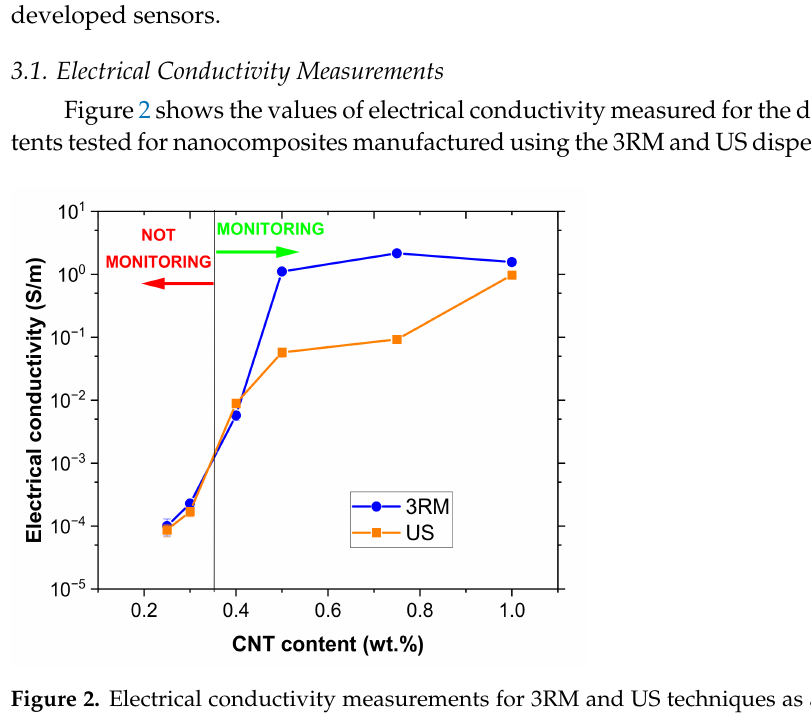
Figure 2. Electrical conductivity measurements for 3RM and US techniques as a function of CNT